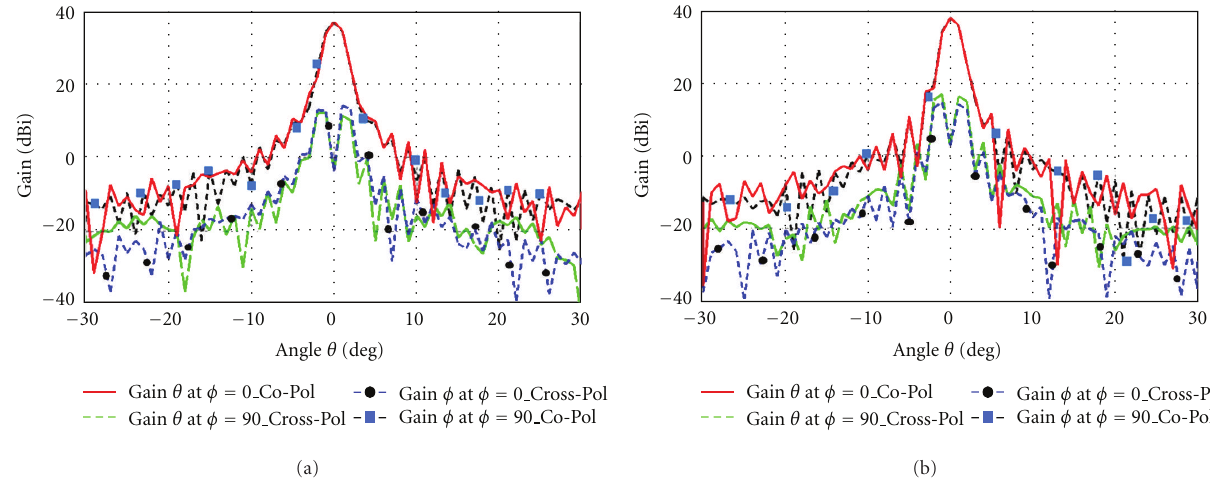
Figure 18: Reflector antenna radiation patterns with the feedhorn mode combination of TE 11 (40%) + TM 01 (30%) + TE 21 (30%) with +90 ◦ phase for (a) 7.45 GHz, and (b)